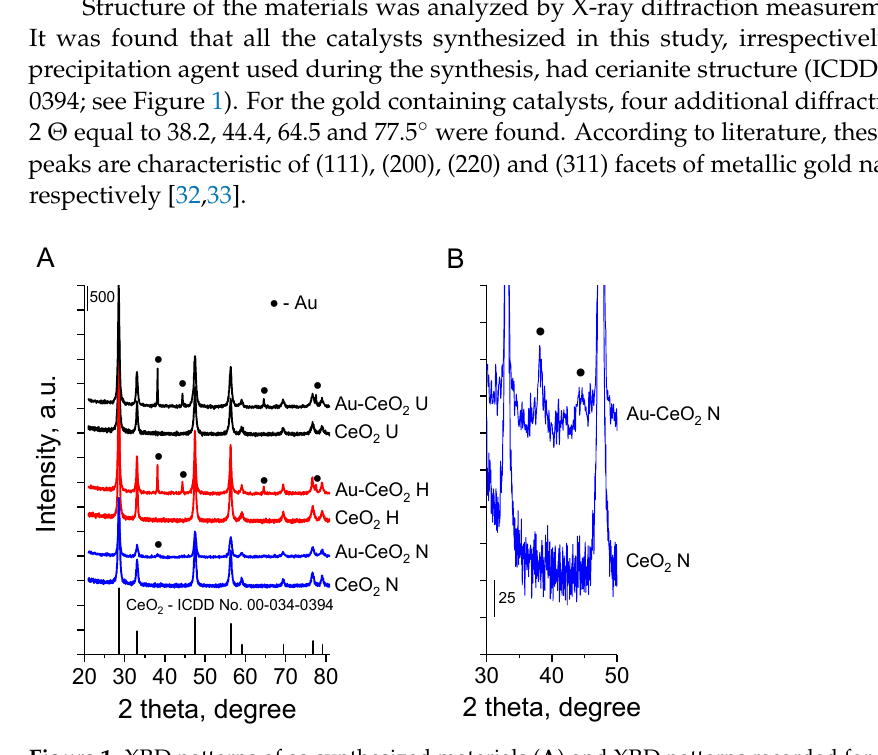
1 estimated using ICP-OES; 2 estimated by Brunauer–Emmett–Teller (BET) method, 3 estimated from adsorption branch using Barrett–Joyner–Halenda (B.J.-H.) method; 4 estimated from XRD patterns using the Scherrer equation.